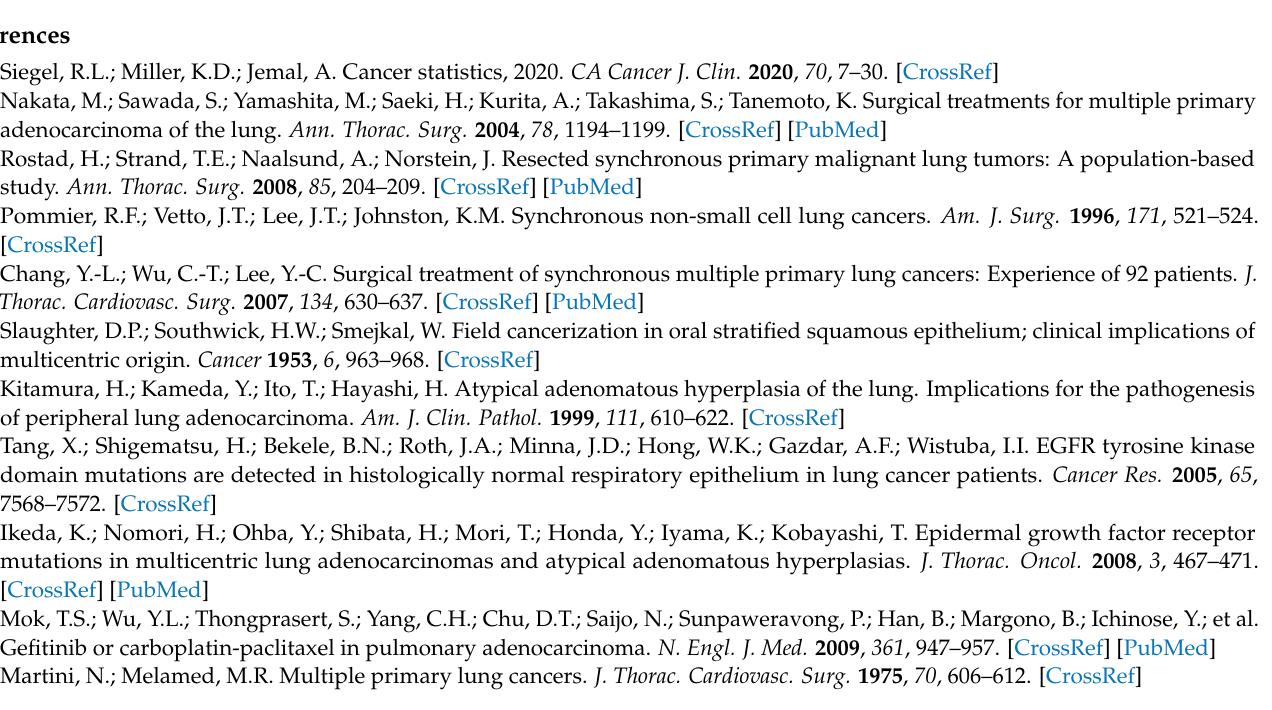
Table S4: Comparison of clinicopathological parameters between patients with molecular-concordant and molecular-discordant